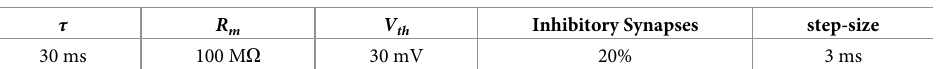
Table 1. Parameters used for our neuron